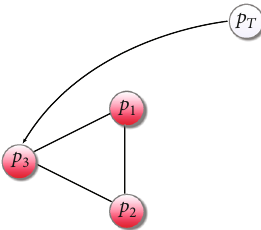
Figure 4: A minimally rigid undirected graph adopted for